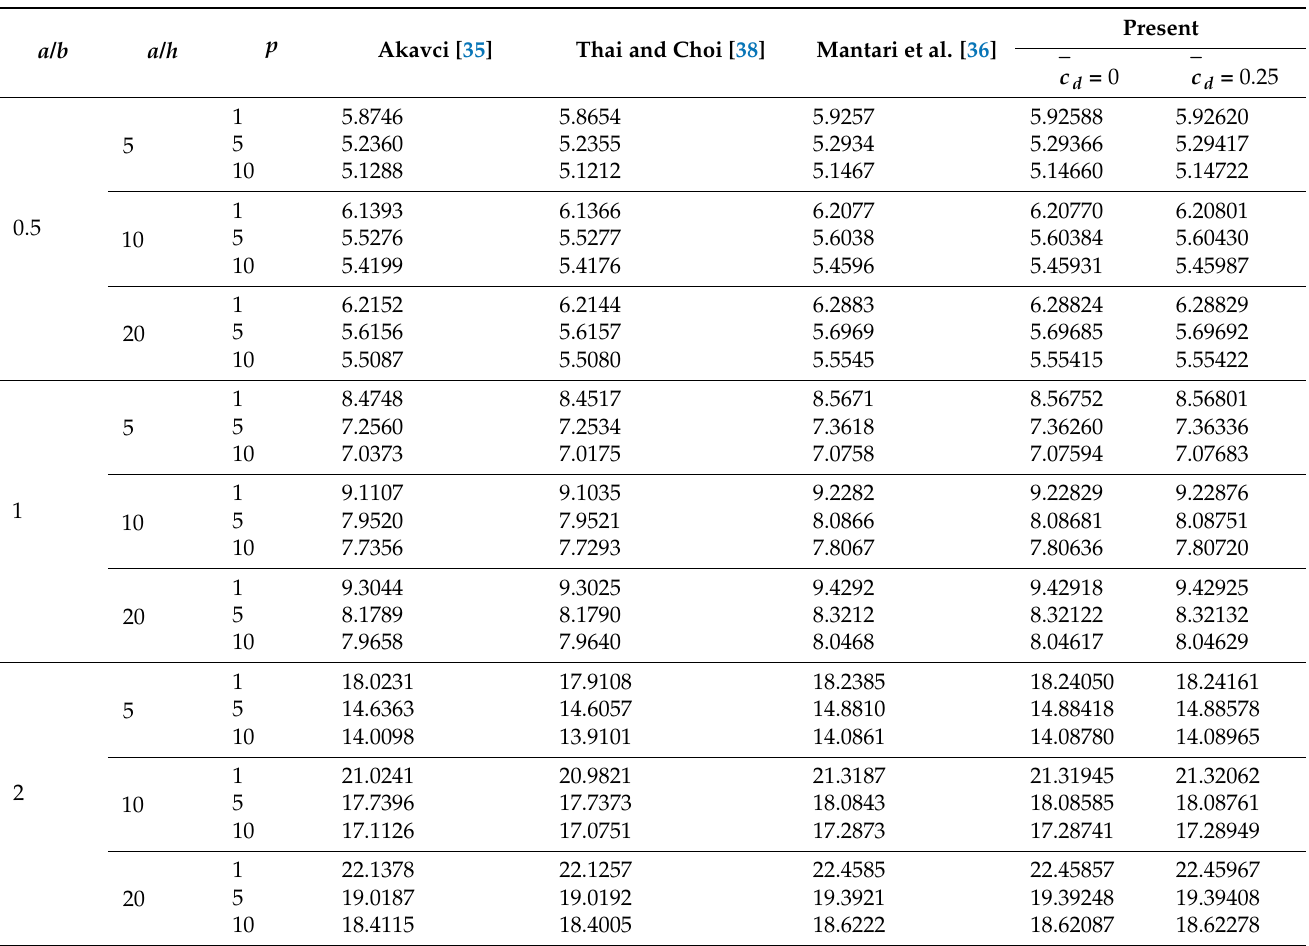
Table 12. Non-dimensional fundamental frequencies ˇ ω = rectangular plates resting on visco-Winkler foundations ( k w = 100, k s =